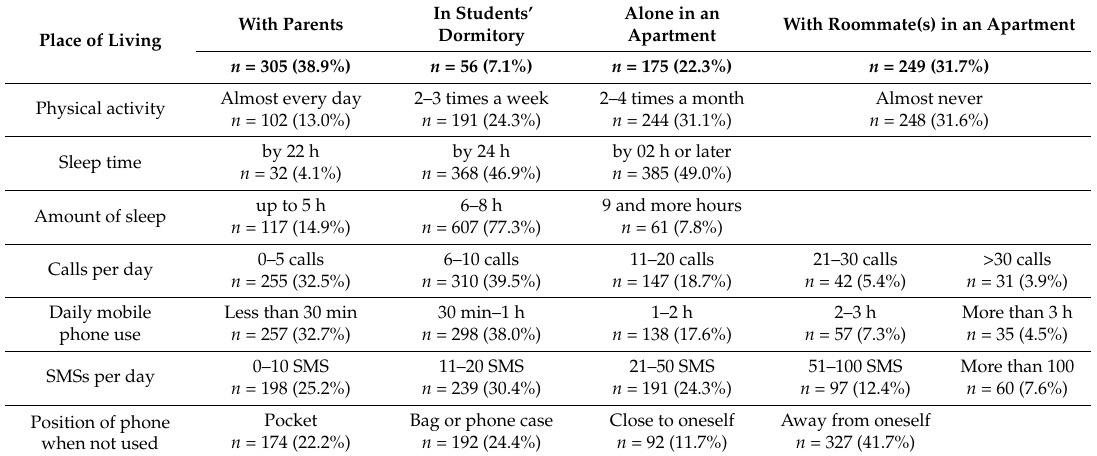
Table 2. General characteristics of the surveyed